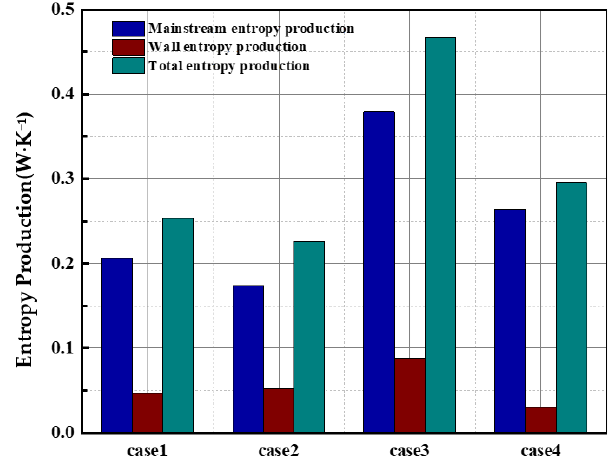
Figure 9. Dissipation entropy production value of each case.